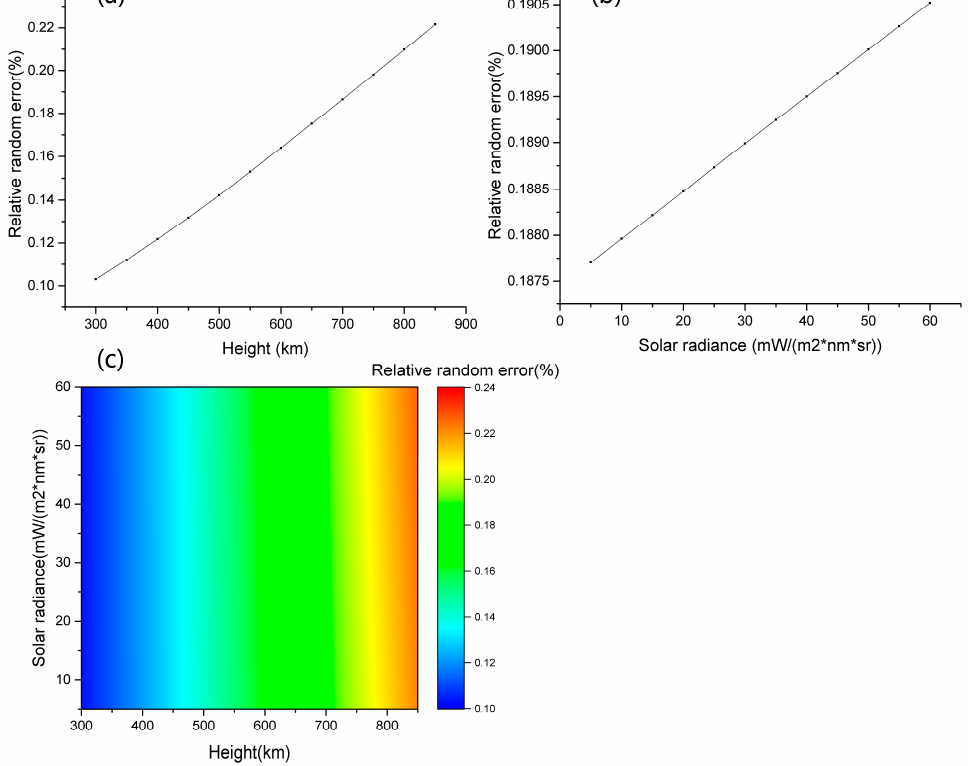
Figure 3. The effect of orbit parameters on the relative random error. ( a ) The relationship between the orbit height and the relative random error. ( b ) The relationship between the solar radiance and the relative random error. ( c ) The combined effect of the two factors.